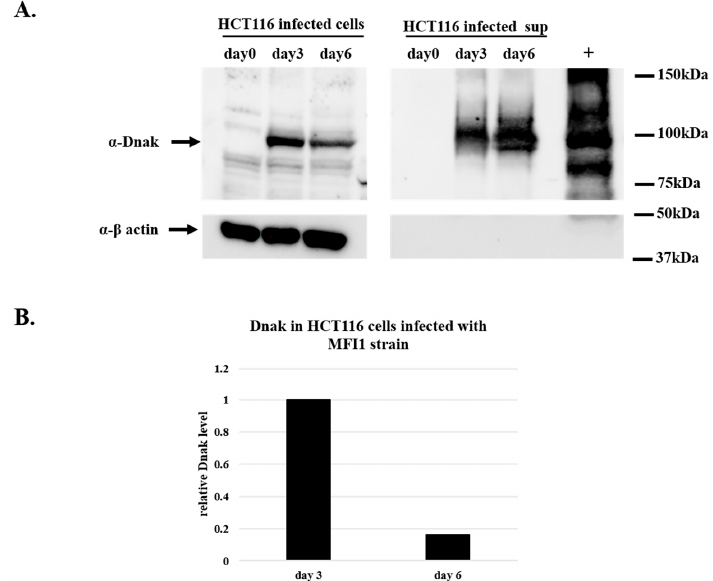
Figure 2. Western blot analysis of DnaK protein in lysates from HCT116 cells infected with MF-I1. Cells were infected with MF-I1 and at day 0, day 3, and day 6 cells and corresponding supernatants were harvested. To ensure the recovery of intracellular Mycoplasma and removal of extracellular mycoplasma from the cells, HCT116 infected cells were treated with gentamicin 400 μ g/mL and 0.005% Triton x-100 two hours after removal of the supernatant before harvesting the cells. ( A ) Cellular proteins and cleared supernatants were separated by SDS-PAGE and analyzed by Western blot using anti-DnaK and anti- β actin antibodies. ( B ) The relative amount of DnaK protein in HCT116 cells was calculated by using ImageJ software (NIH, Bethesda). In agreement with q-PCR and Western blot, CFUs/mL of MF-I1 in the supernatants from infected HCT116 cells increased 4.1 fold (Table 1) from day 1 to day 3 post-infection